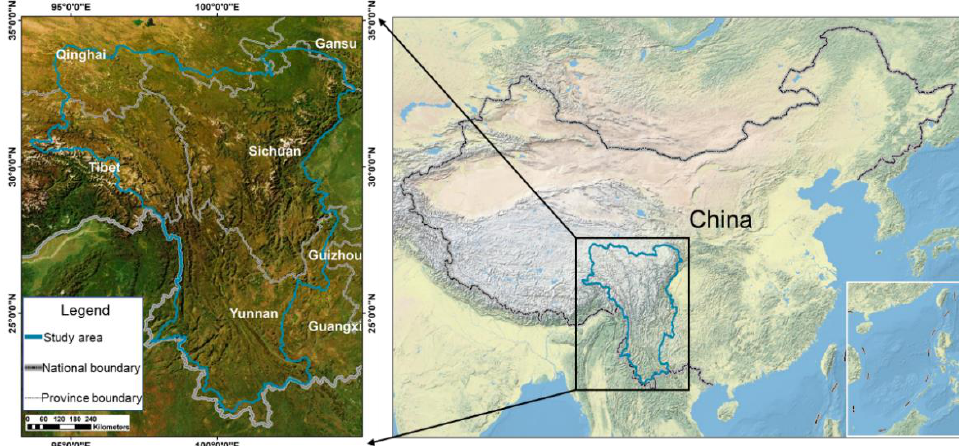
Figure 1. The study area is located in the SSW of China, with an area of more than 700,000 square kilo- meters.